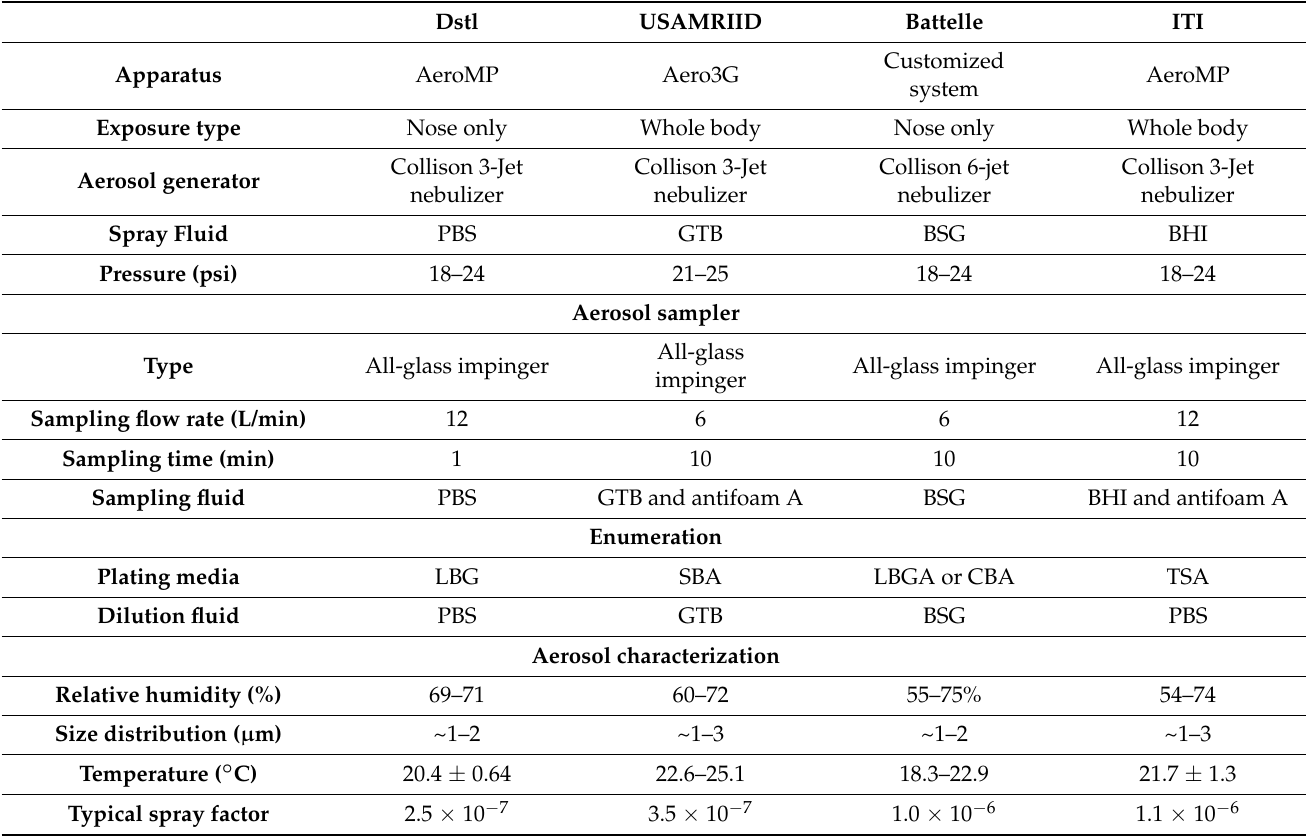
Table 3. Aerosol